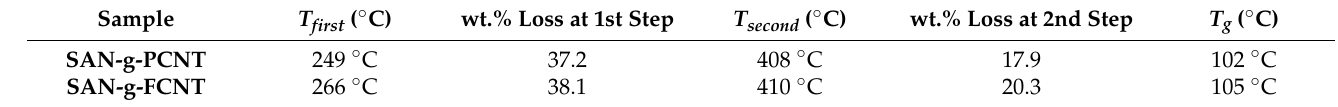
Table 1. Thermal results of SAN-g-FCNT and SAN-g-PCNT obtained from TGA and DSC.